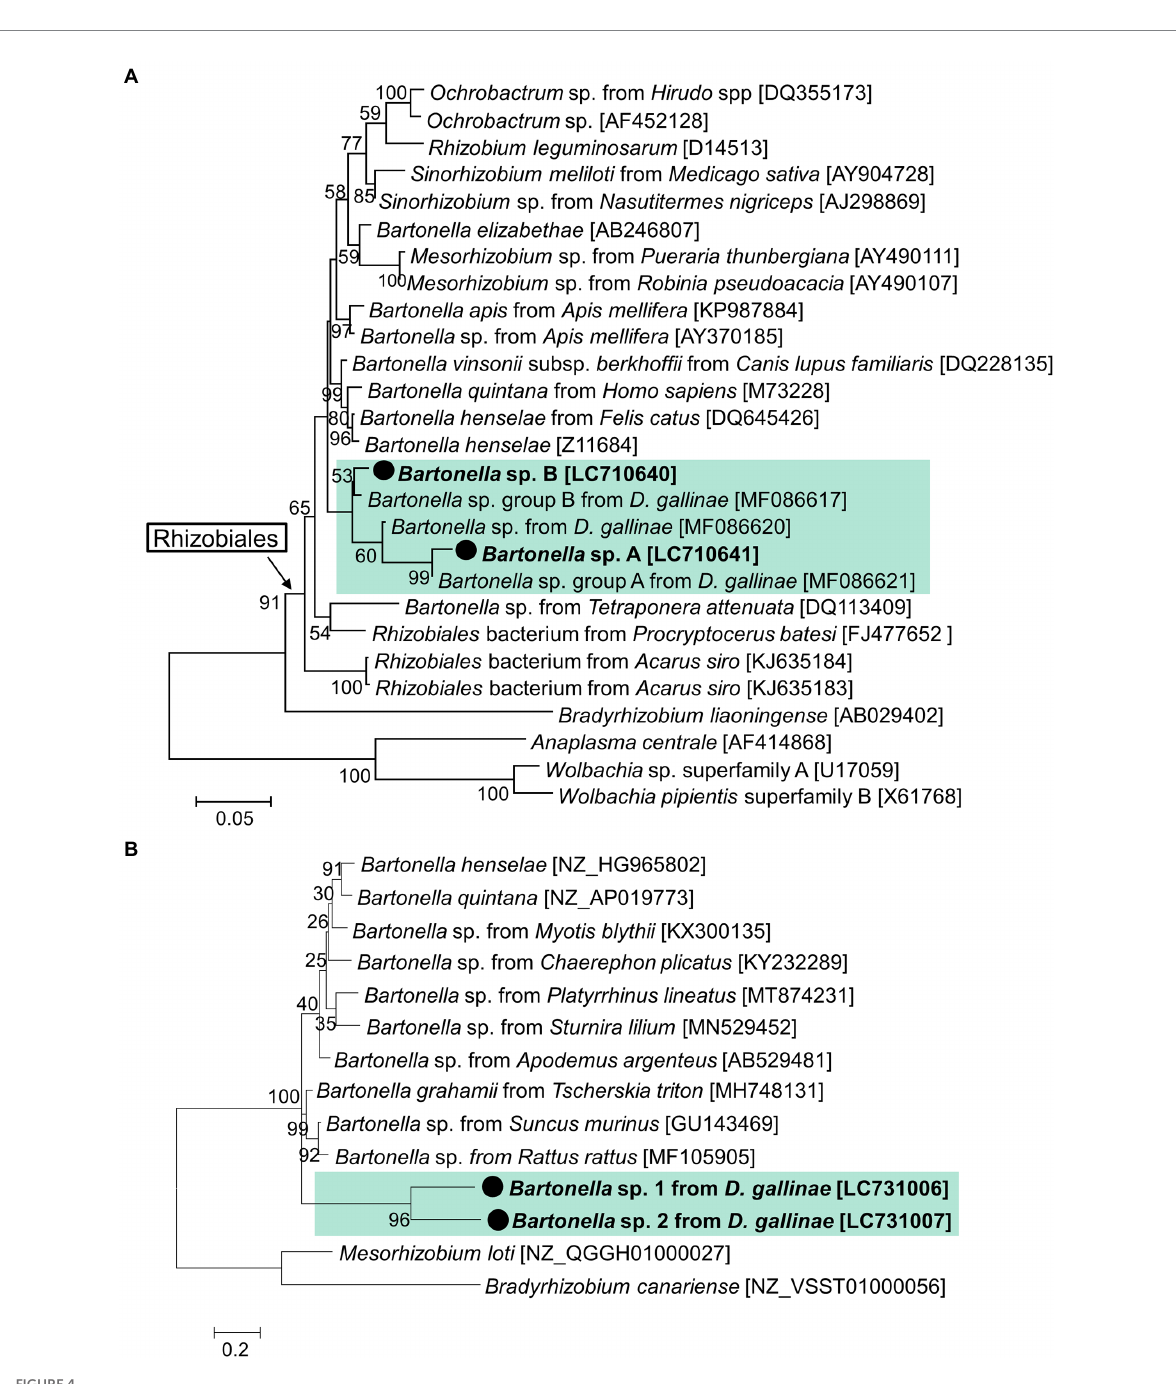
FIGURE 4 Phylogenetic relationship of the 16S rRNA sequences (A) and rpoB (B) of Bartonella and related species. (A) A maximum-likelihood phylogeny (model K2 + G + I) inferred from 1,175 aligned nucleotide sites are shown with bootstrap probability at each node. (B) A maximum-likelihood phylogeny (model K2 + G) inferred from 385 aligned nucleotide site. The sequences in bold with black circle are those obtained in this study. OTU of Bartonella from D. gallinae are shaded with light green. Numbers in square brackets indicate NCBI accession